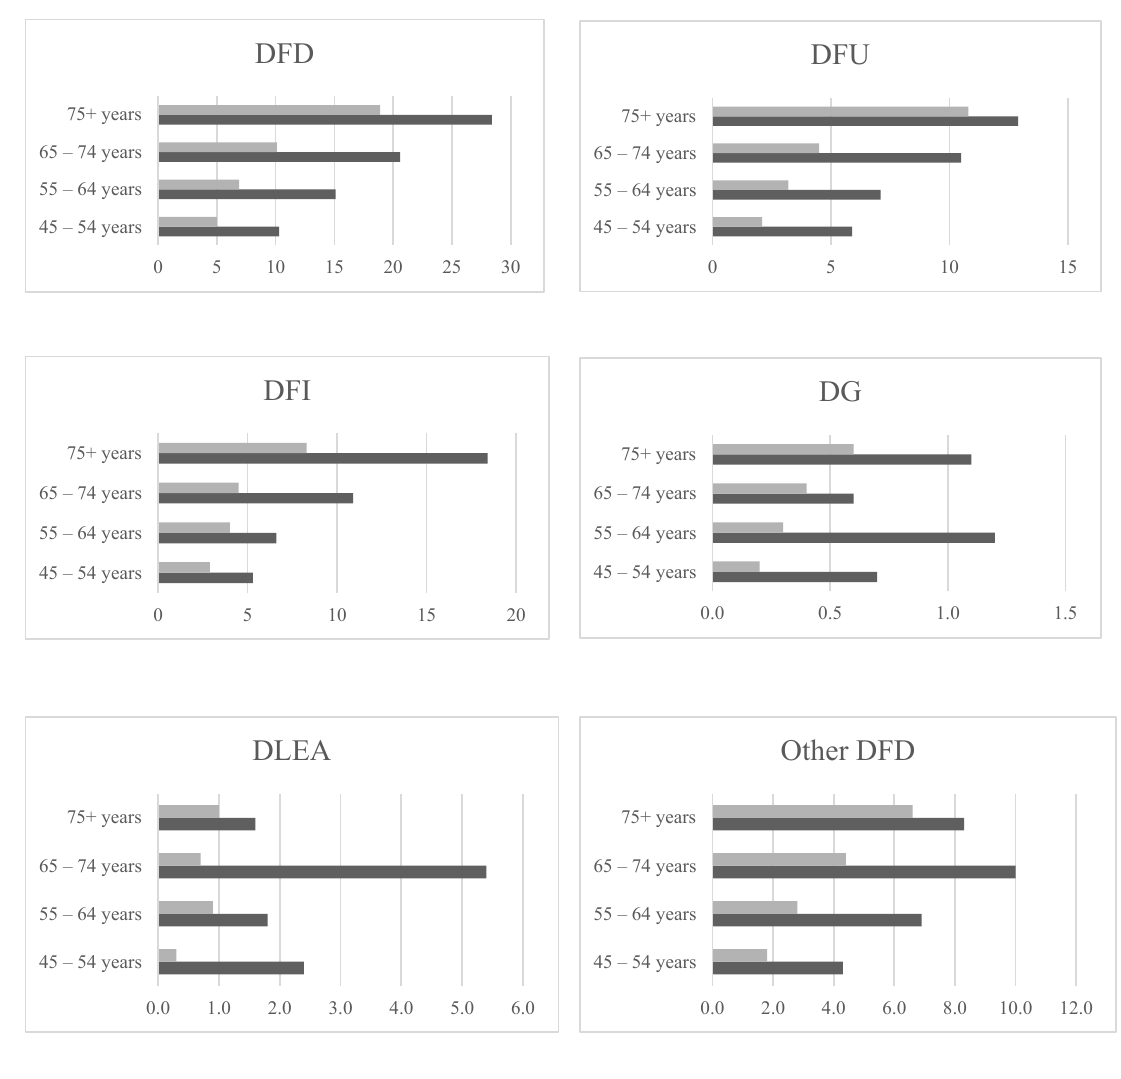
Figure 3. Prevalence of diabetic foot complications by age groups and type of diabetes.